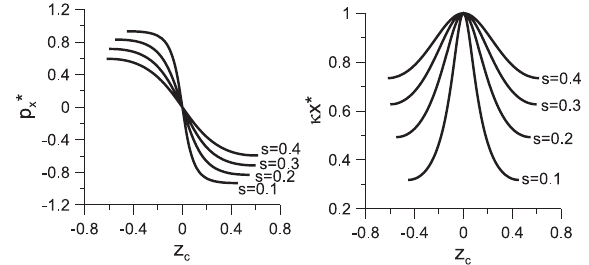
Fig. A1. Slow coordinates p ∗ x , κx ∗ along the uncertainty curve are shown as functions of z c for various s